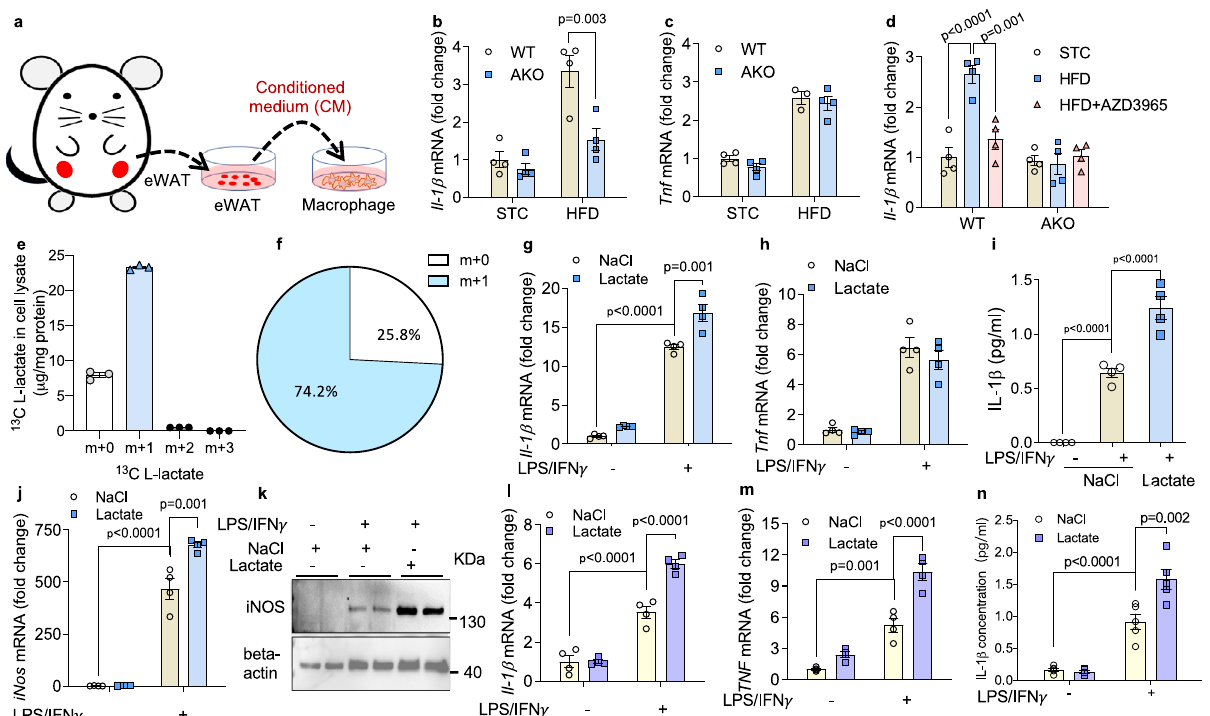
Fig.4|LactatepotentiatesIL-1 β expressioninmouseandhumanin fl ammatory macrophage. a – d Conditioned medium (CM) of epididymal white adipose